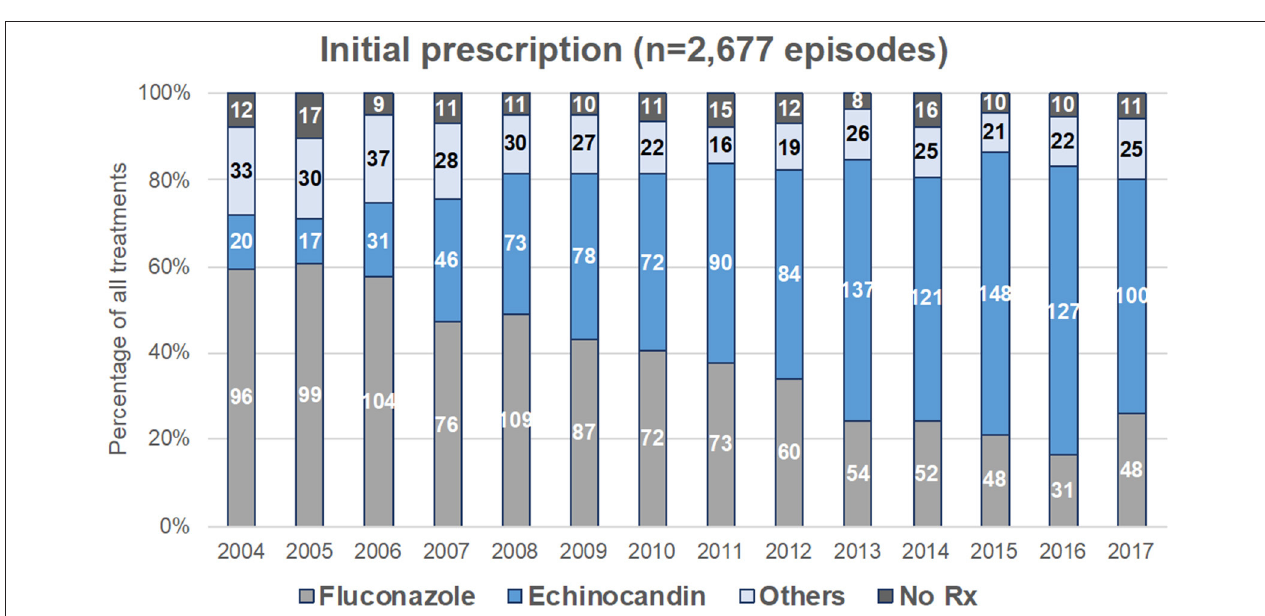
FIGURE 3 | Evolution of first-line antifungal drug prescription for treatment of yeast fungemia (YEAST program, Paris area, 2004–2017). First-line treatment was analyzed for the 2,677 episodes for which time to potential death exceeded 48h. Figures represent the number of episodes treated each year by fluconazole alone, echinocandin alone, other treatments (liposomal amphotericin B, voriconazole, posaconazole, itraconazole, or drug combination), or not treated.